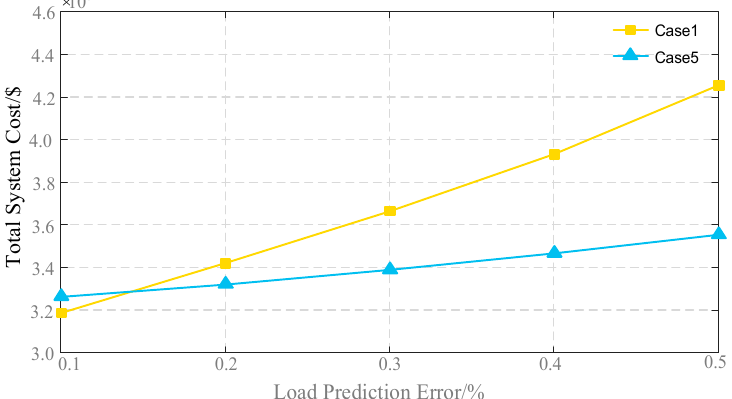
Figure 9. The change curve of integrated scene system operation cost under di ff erent load prediction errors.